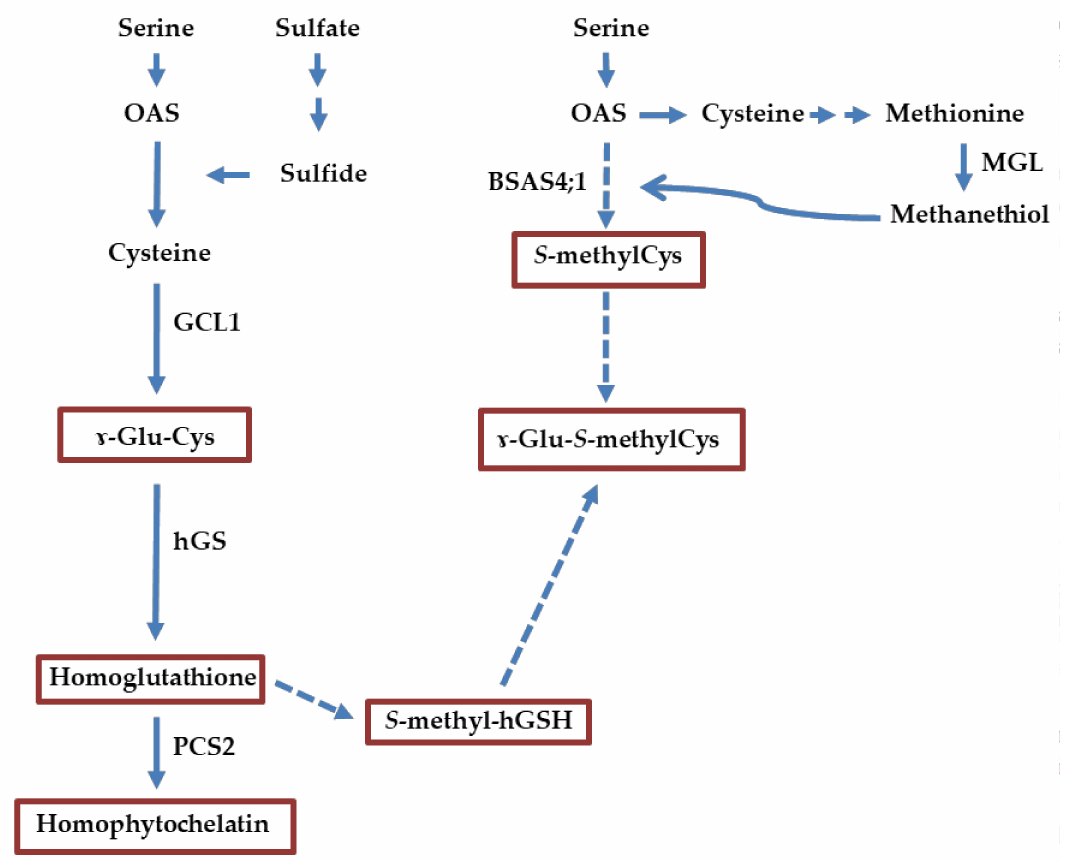
Figure 1. Possible biosynthetic pathway of sulfur amino acids in seed of the common bean. Solid arrows indicate steps taking place in seeds based on gene expression analysis. Multiple arrows refer to multiple steps. Broken arrows represent hypothetical steps. Metabolites in boxes are related to S -methylcysteine and were profiled in this study. The predominant pathway of cysteine biosynthesis in seed is cytosolic and BSAS4;1 is the main cytosolic cysteine synthase expressed in seed. Formation of free S -methylcysteine by cysteine synthase is inferred from data in Arabidopsis. The presence of S -methylhomoglutathione suggests a pathway similar to that of the S -alk(enyl) sulfoxides in Allium leading to the formation of γ –glutamyl- S -methylcysteine (see text for details). OAS: O